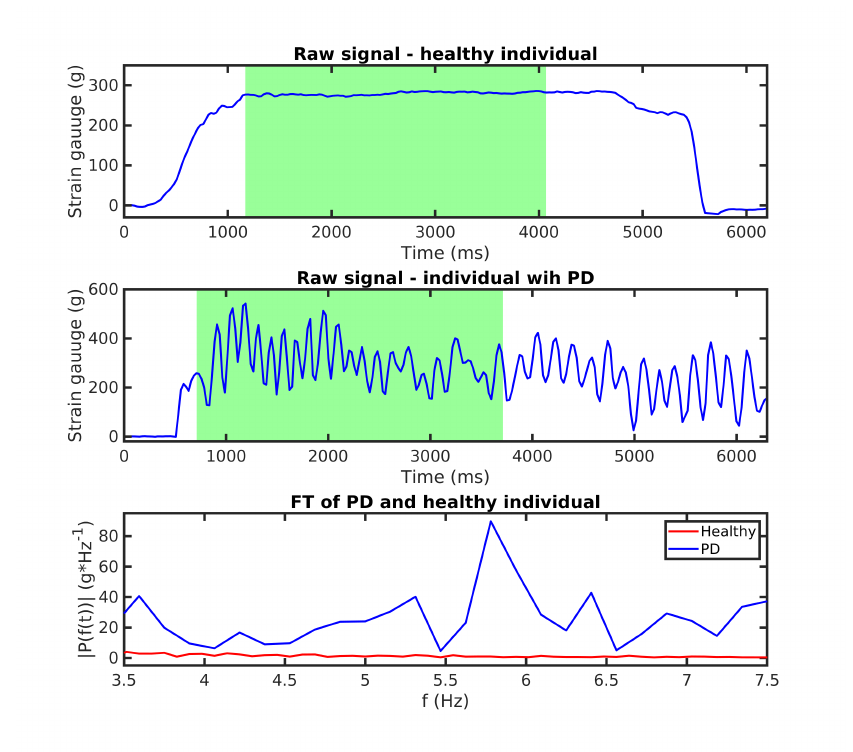
Figure 8. Comparison of healthy individual exercise and exercise for a patient with PD. Resampled values of FT transform (3rd) are used as input to our